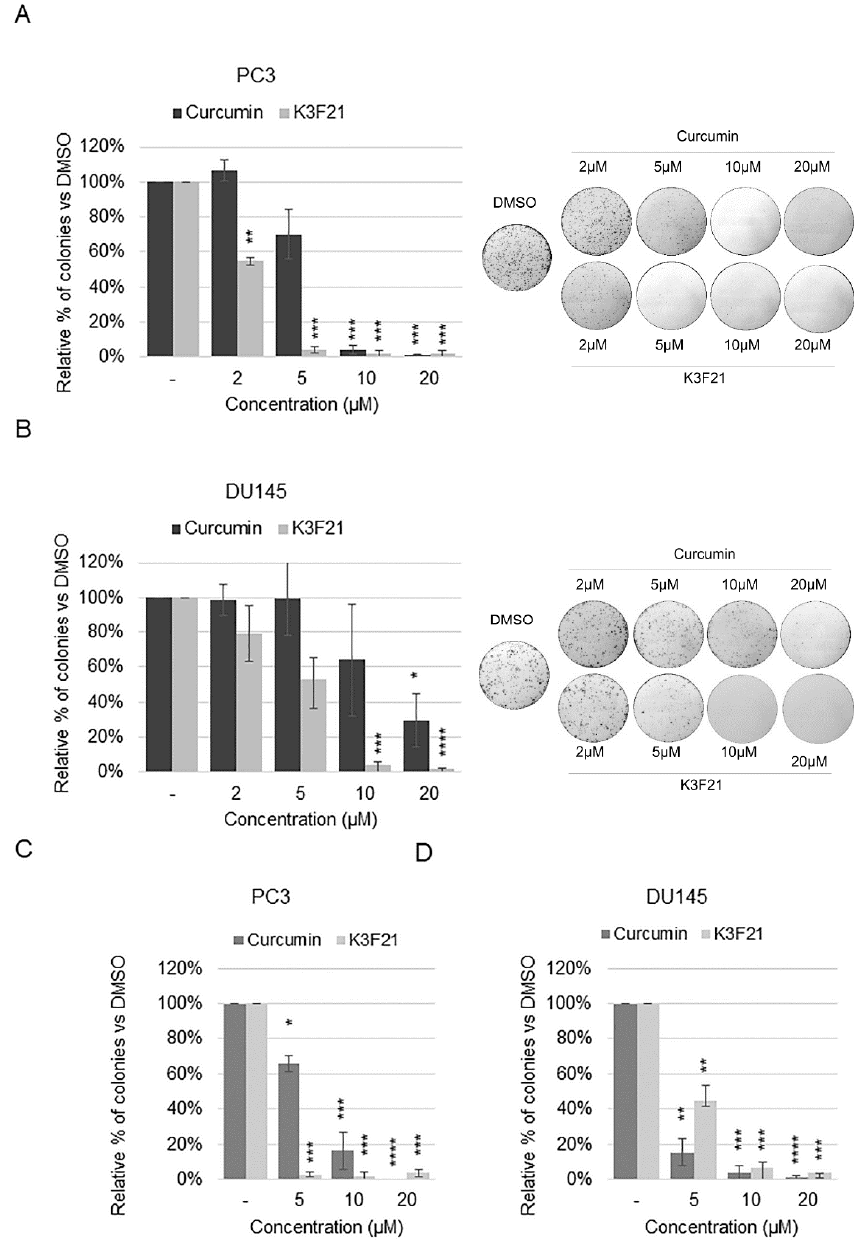
Figure 8. K3F21 inhibits colony formation of PCa cells. The number of colonies in PC3 and DU145 cells cultured in anchorage-dependent ( A , B ) or anchorage-independent conditions ( C , D ) in the presence of increasing doses of curcumin and K3F21 is reported as percentage versus DMSO treated cells, arbitrarily set at 100%. Data are the mean of three independent experiments ± SEM. P values refer to the comparison between curcumin and K3F21 with DMSO samples: * < 0.05, ** < 0.01, *** < 0.001, **** < 0.0001. Representative images of anchorage-independent colony assay are shown in Supplementary Figure S6.